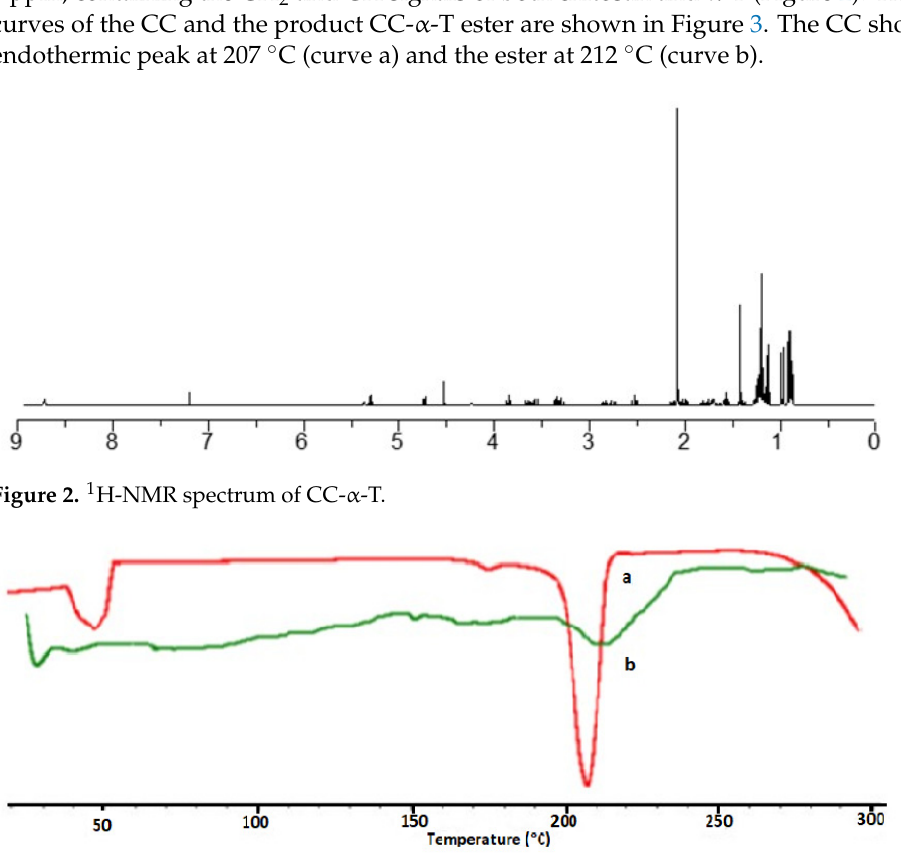
Figure 3. DSC curves of CC ( a ) and CC- α -T ( b ).